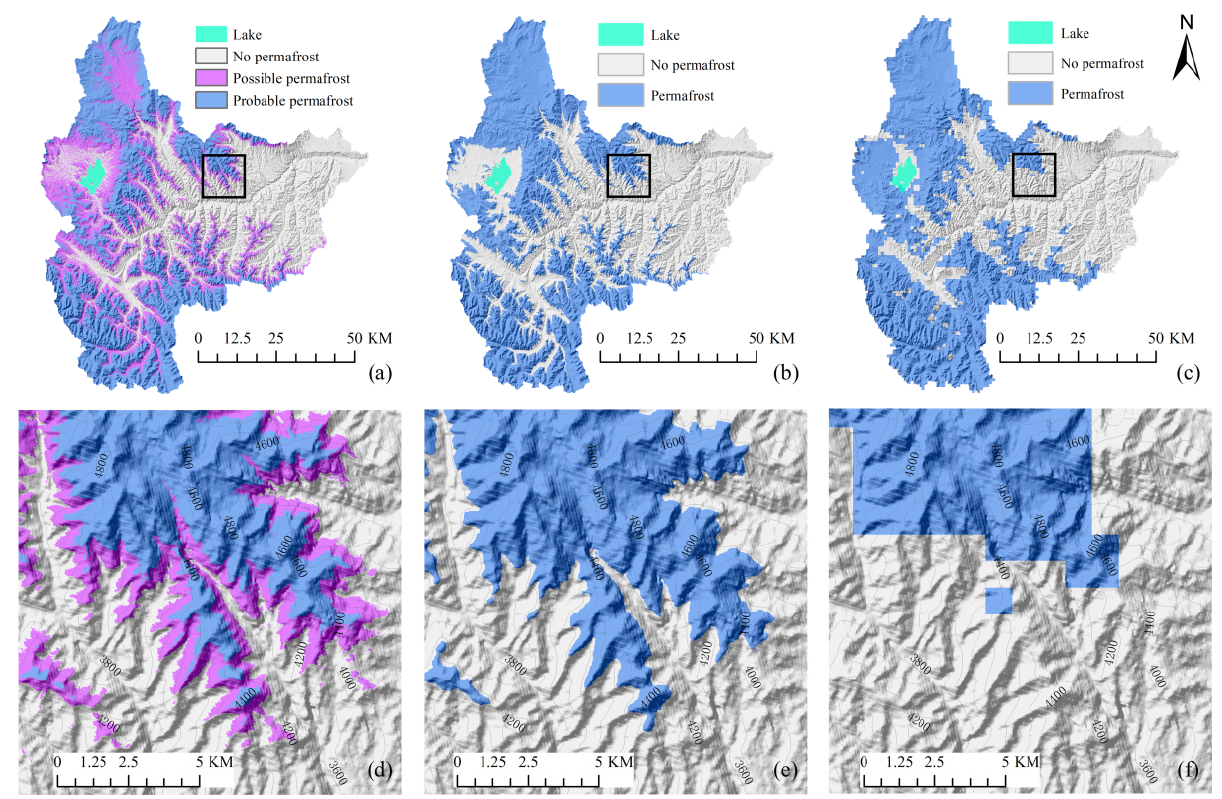
Figure 9. Maps of frozen ground distribution in the study area. ( a ) Our method; ( b ) map based on Nan’s model in 2002; ( c ) map produced by Zou in 2017; ( d – f ) enlarged views of the three different maps, respectively.